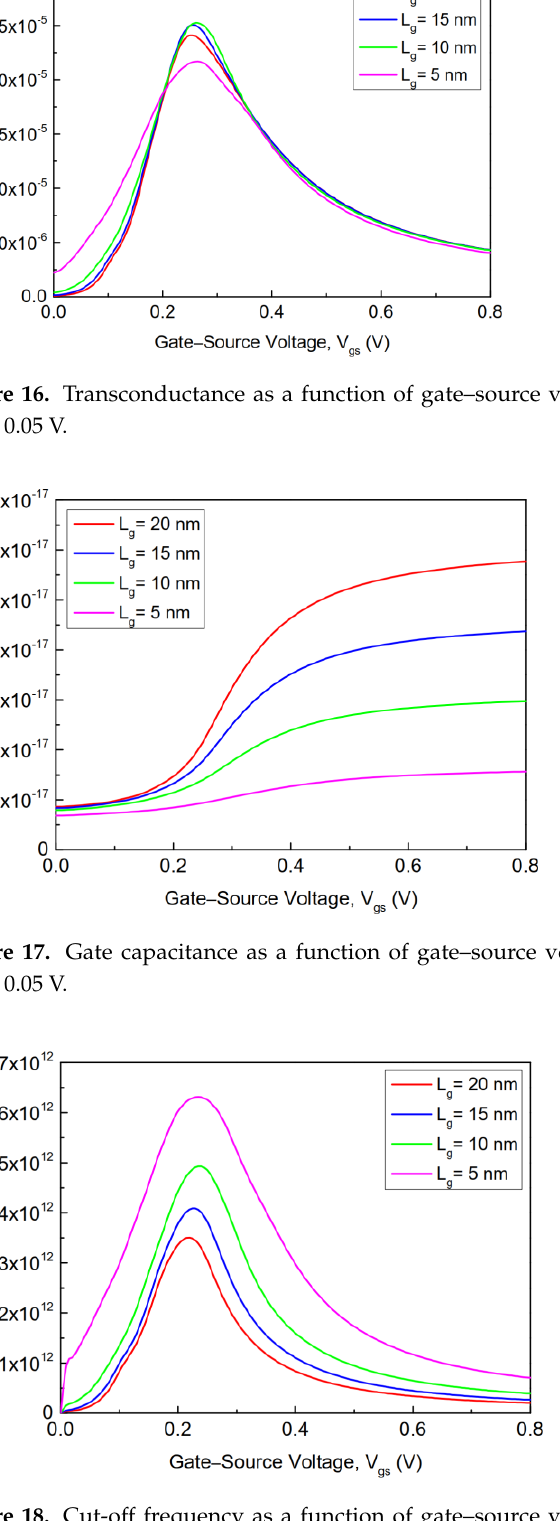
Figure 19. Transfer characteristics logarithmic scale for FinFET devices with different gate lengths at V ds = 0.8 V.